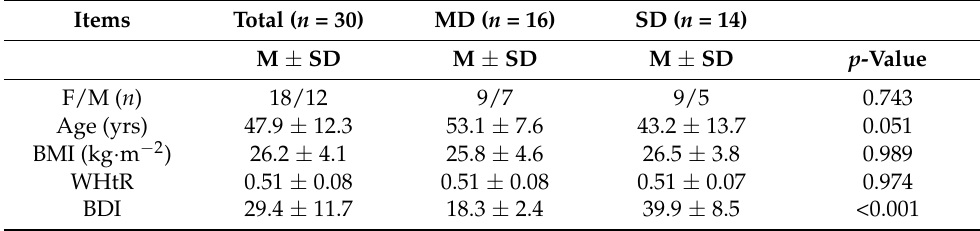
Table 1. Baseline demographic characteristics of patients (means (M) ± standard deviations